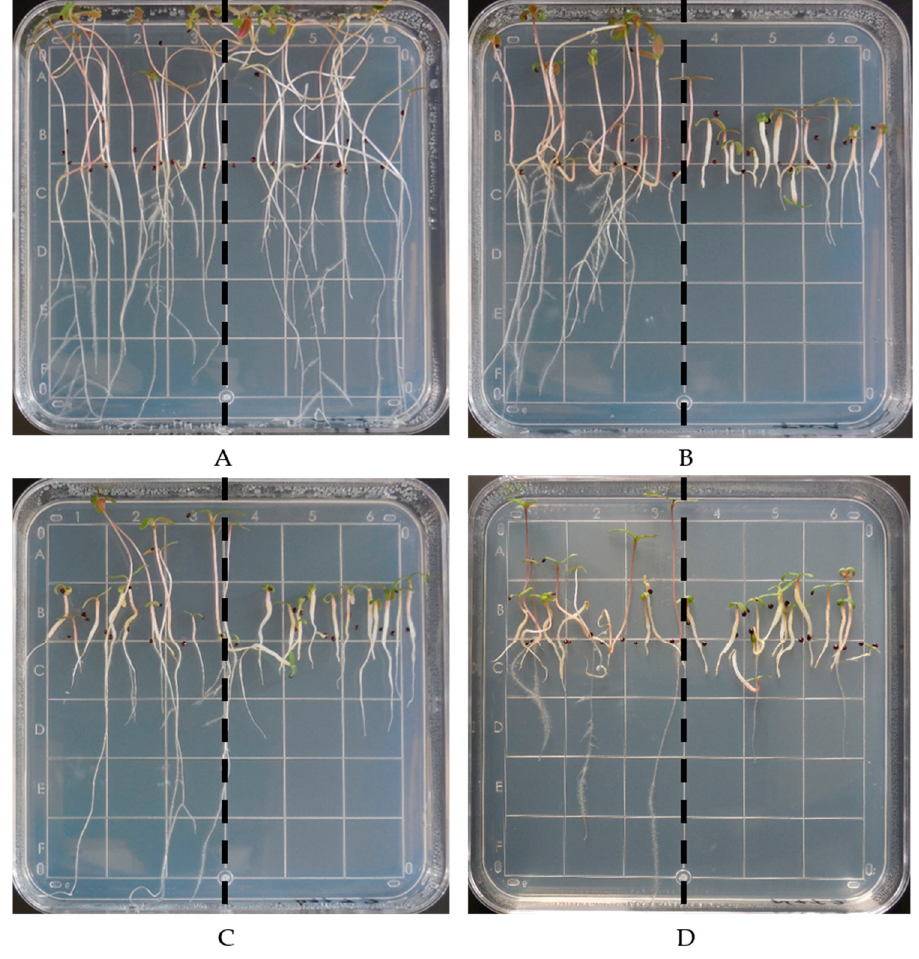
Figure 2. Representative agar plates showing the response of A. palmeri seedlings under different treatments. Control ( A ); trifluralin 1 µM ( B ); trifluralin 1 µM + malathion 8 µM ( C ); and trifluralin 1 µM + NBD-Cl 50 nM ( D ). In all plates, left and right sides correspond to resistant and susceptible accession seedlings, respectively. Photographs were taken at 10 days after treatment.